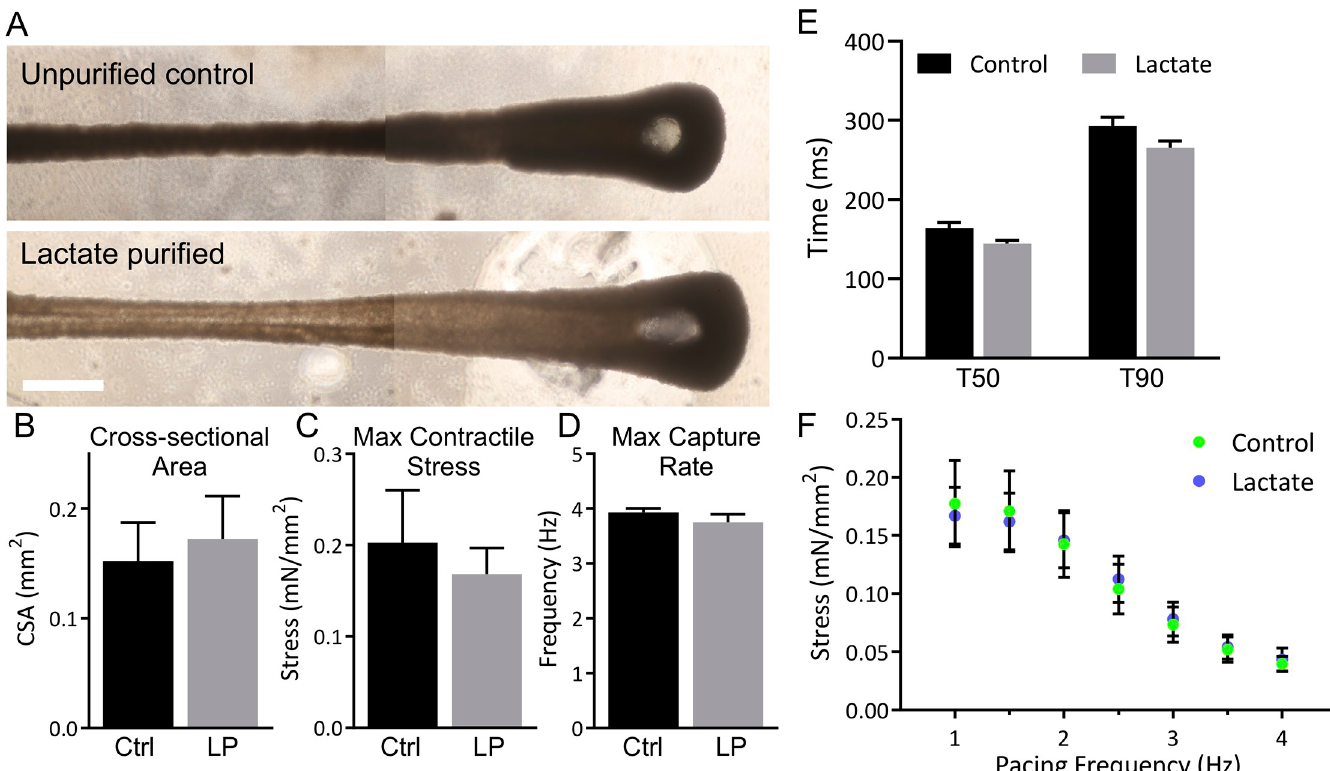
Fig 5. Lactate purified cardiomyocytes do not alter tissue formation via compaction and electromechanical function at one week. (A) Engineered cardiac tissues made with 5% human cardiac fibroblasts (hCFs) and unpurified hiPSC-cardiomyocytes (38% cTnT+; top) or lactate purified hiPSC-cardiomyocytes (82% cTnT+; bottom) were cultured for one week. Scale bar: 1 mm; images stitched together. (B-F) Control tissues (Ctrl, n = 8) and tissues with lactate purified cells (LP, n = 4) underwent mechanics testing at 1 week. Cross-sectional area (B), maximum twitch contraction stress (C), and maximum capture rate (D) were measured. (E) Relaxation time to 50% (T50) and 90% (T90) of maximum stress was measured. (F) Maximum stress production was measured at increasing pacing frequency. Data are represented as mean ± SEM.